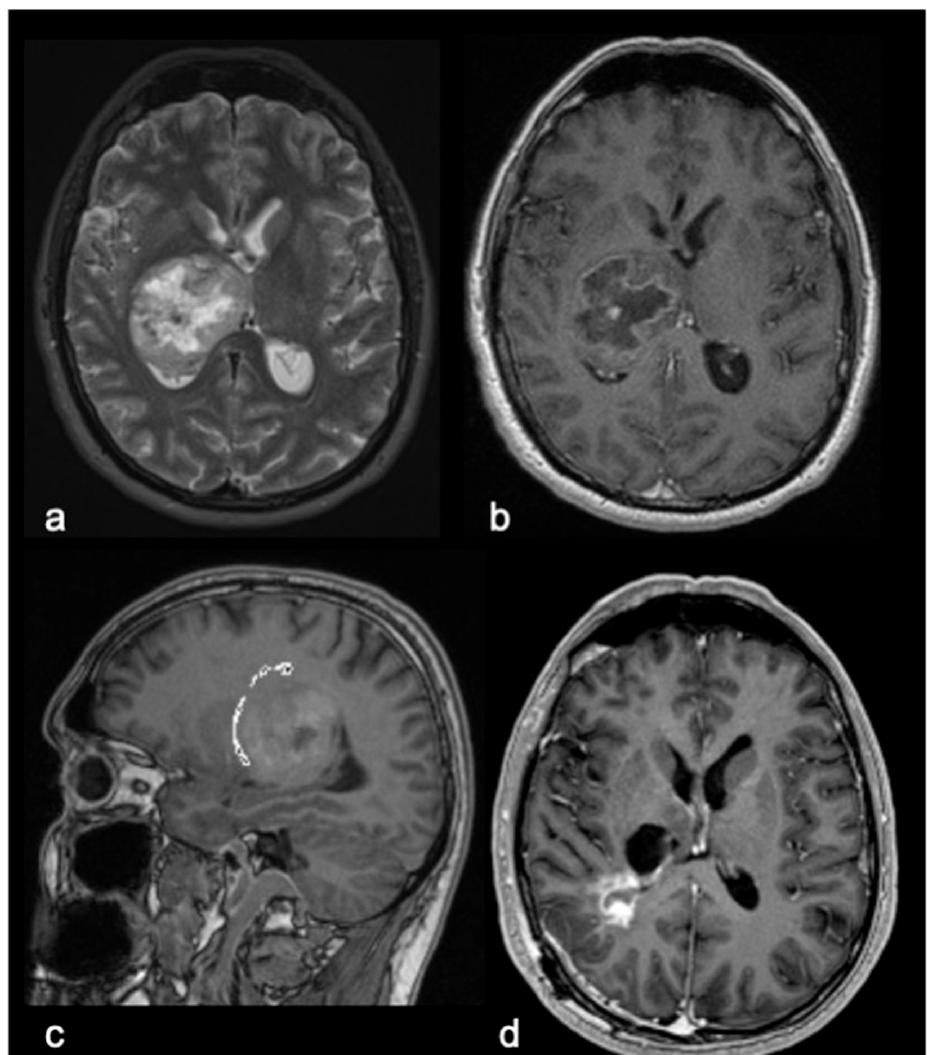
Figure 1. An illustrative case of a 51-year-old right-handed male with a 3-month history of rapidly progressive right sensorimotor syndrome. ( a ). Axial T2-weighted Brain Magnetic Resonance imaging (MRI). ( b ). Axial postcontrast T1-weighted MRI and Sagittal T1-weighted MRI with tractographic reconstruction ( c ) of the right corticospinal tract, demonstrating a voluminous ring-enhancing right thalamic lesion. The patient underwent surgical removal of the lesion through a right trans-parietal approach. ( d ). Axial postcontrast T1-weighted MRI showing subtotal removal of the lesion. Postoperatively, the patient presented a transient worsening of right hemiparesis with recovery through rehabilitation after about 1 month. Histological examination confirmed an IDH wild-type glioblastoma. The patient underwent adjuvant therapy with Temozolomide and concomitant Radiotherapy, Regorafenib and Lomustine, with a survival of 18 months.